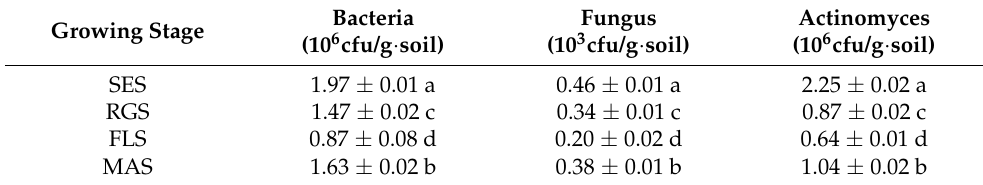
Table 4. Effect of different growth stages on rhizosphere soil microbial